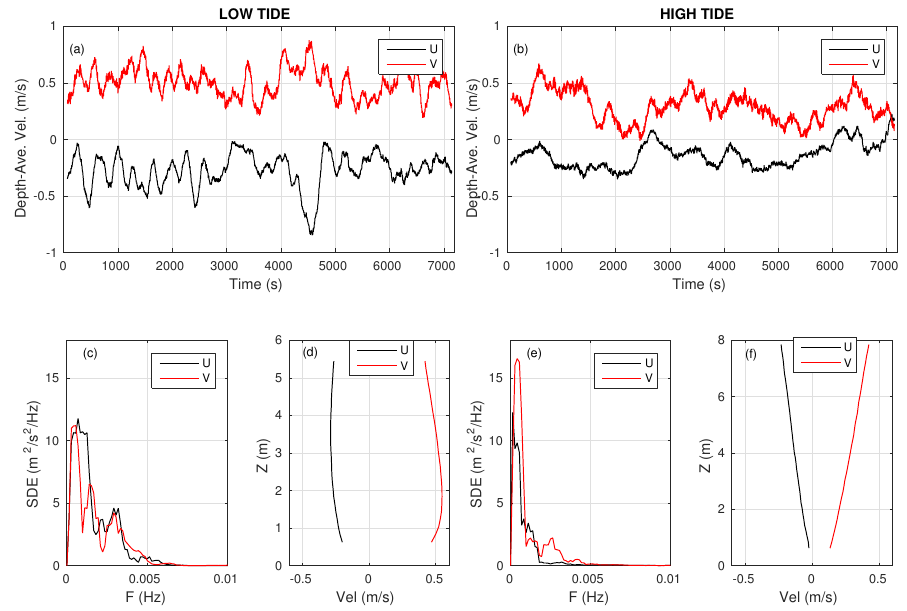
Figure 7. High-energy deflection rip on 10 March 2019 at low (left-hand panels) and high (right-hand panels) tide with cross-shore and alongshore depth-averaged velocity components in red and clack, respectively. ( a , b ) 2-h burst of 2-min moving averaged velocities; ( c , e ) spectral density of energy; ( d , f ) burst-averaged velocity